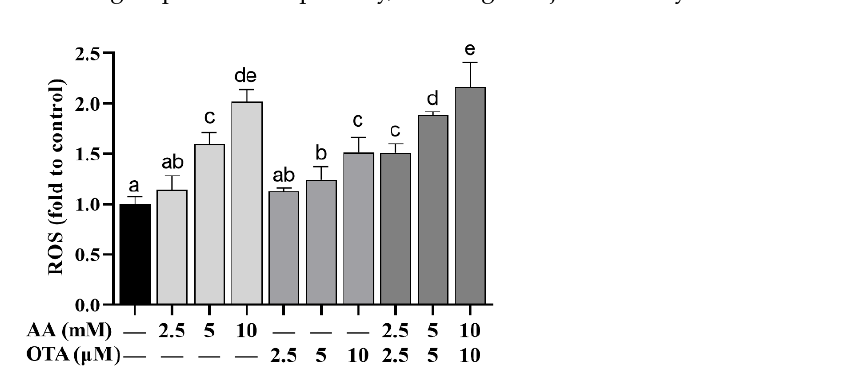
Figure 5. Effect of AA and OTA on ROS production. a–e Different letters indicate significant differ- ences, p < 0.05.